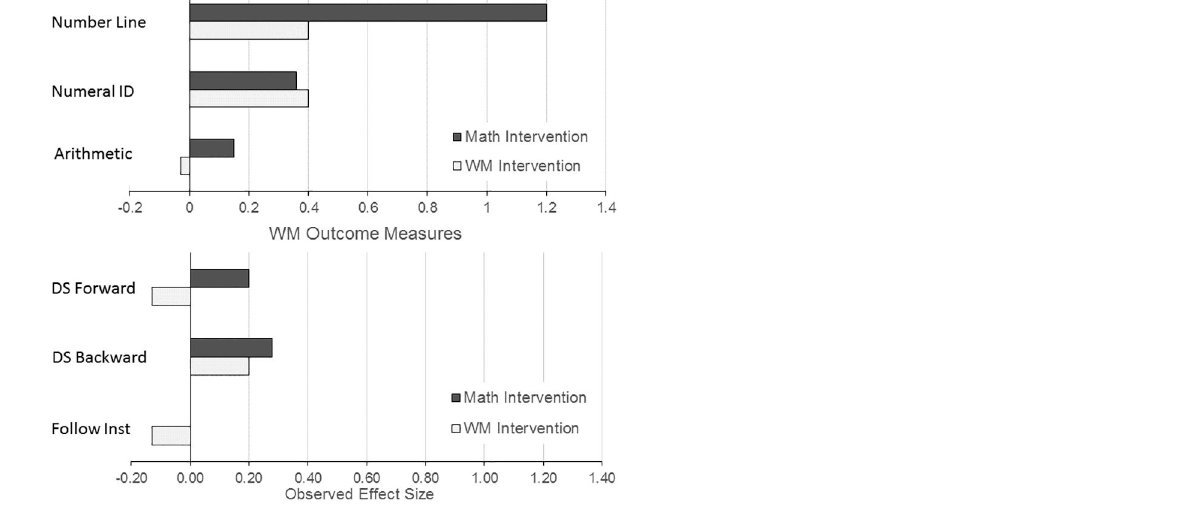
Figure 5. Observed net effect sizes (Cohen’s d) of performance gains from pre-test to post-test for the Math and WM outcome measures. Bars show net effect sizes (standardized changes in the trained group minus standardized changes in the control group), separately for the participants who completed the math intervention (dark bars) and those who completed the WM intervention (light